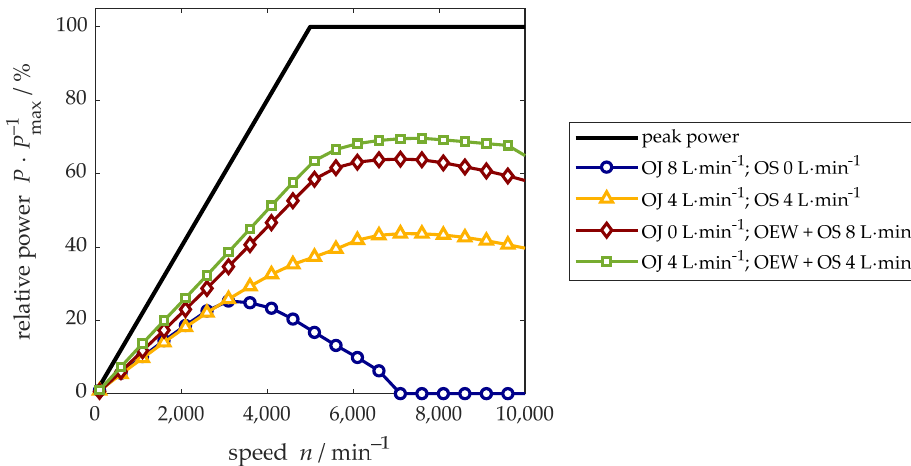
Figure 7. Continuous power as a function of machine speed for different oil volume flow rates in the rotor shaft (OS), the stator jacket (OJ) and the end winding cooling (OEW) for the reference machine at a constant inlet temperature.